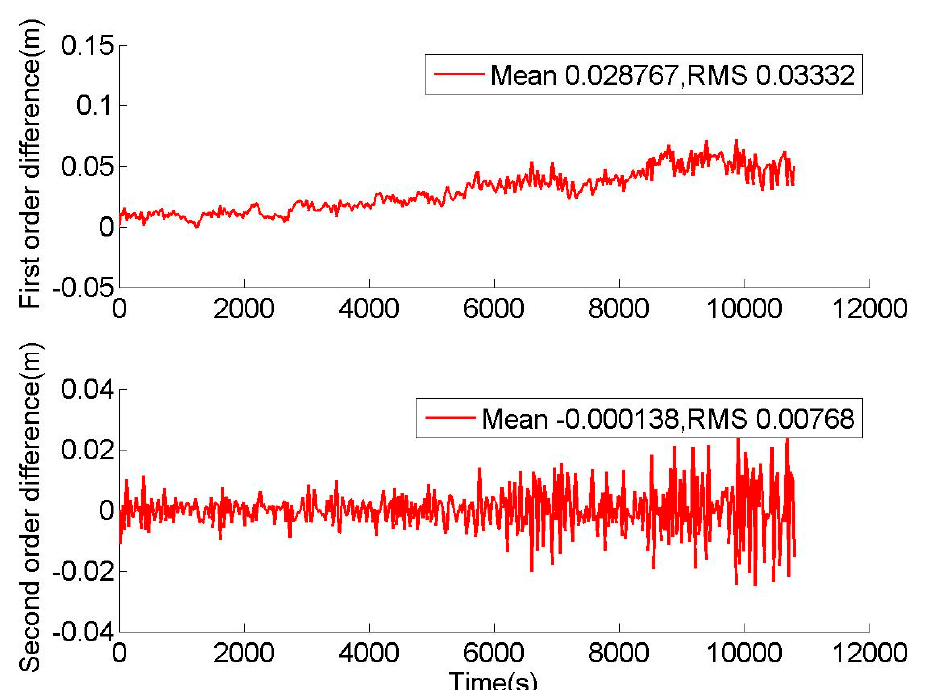
Figure 1. The first-order and second-order differences of the ionospheric delays on the high-dynamic medium earth orbit (MEO) Satellite 11 during the geomagnetic storm, which was calculated by the Beidou navigation satellite system (BDS) dual-frequency data, started from UTC 8 May 2016 00:00:00 with an interval of 30 s at the CUT0 station.